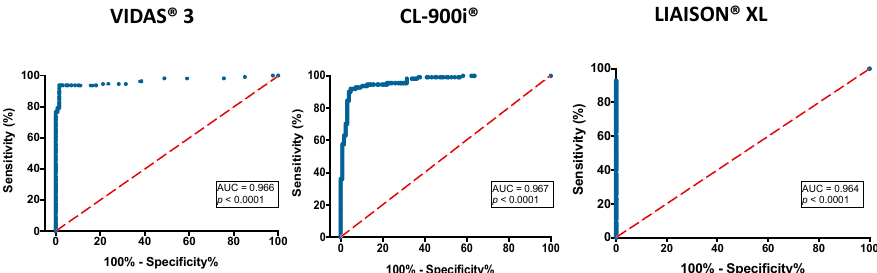
Figure 3. Receiver Operating Characteristic (ROC) curves for each automated analyzer. An AUC of 0.9–1.0 is considered excellent, 0.8–0.9 very good, 0.7–0.8 good, 0.6–0.7 sufficient, 0.5–0.6 bad, and less than 0.5 considered not useful [35] .